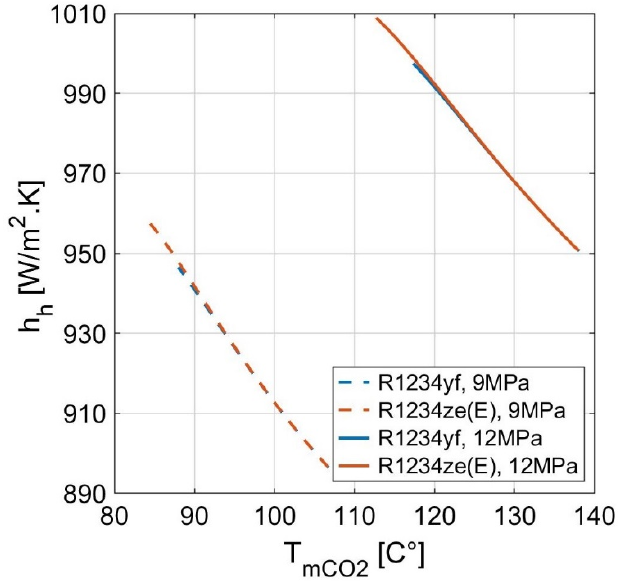
Figure 8. Hot stream convection coefficient at various mean hot stream temperatures.